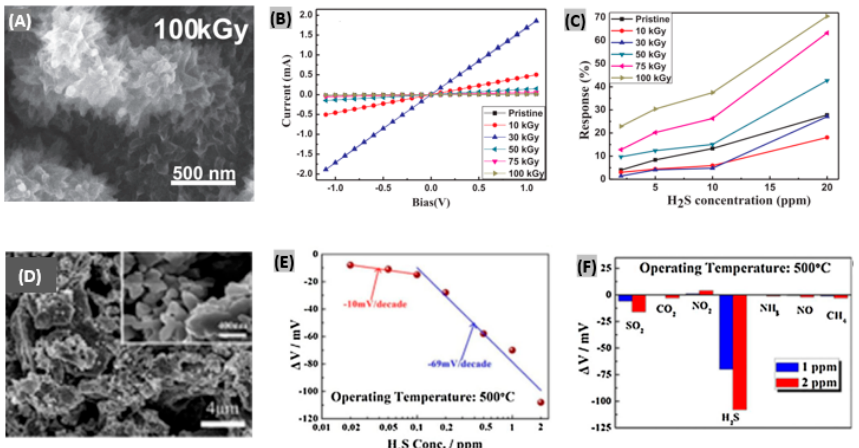
Figure 15. ( A ) FE-SEM image of PANI-Ag film irradiated with EB at 100kGy dose. ( B ) Current-Voltage relationship of PANI-Ag film at pristine and EB irradiated condition. ( C ) Percent sensor responses under different H 2 S concentrations and irradiation doses. Figures adapted with permission from [177], Copyright 2018 Elsevier. ( D ) SEM image of LNO-1 sensing electrode (La 2 NiO 4 ). ( E ) Electrode